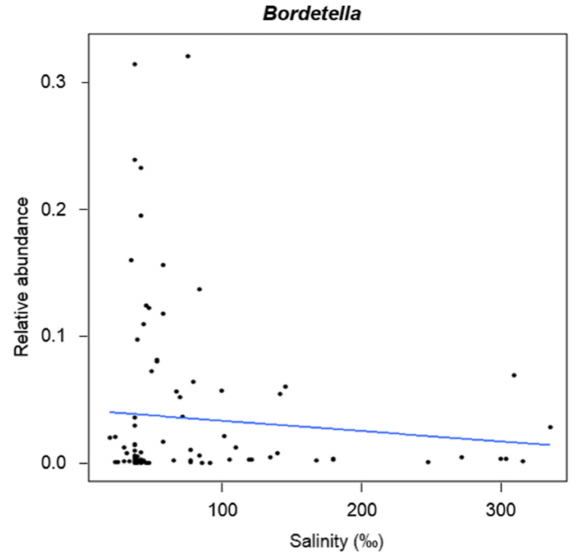
Figure 6. GLM plot showing variation in abundance of Bordetella in relation to the salinity.